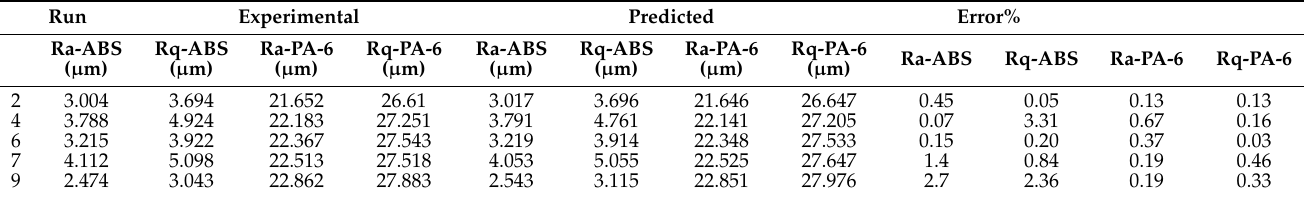
Figure 16. Normal probability graph for the residuals of polymers: ( a ) Ra-PA-6 and ( b ) Rq-PA-6. Conformance tests were performed to verify the constructed models; the results are presented in Table 11. The testing findings were randomly selected from the L9 and L18 orthogonal experimental designs. According to the confirmation findings, it was discovered that the anticipated values from the models and the experimental values were in excellent agreement within the provided parameter range. Table 11. Confirmation model for the developed mathematical model.